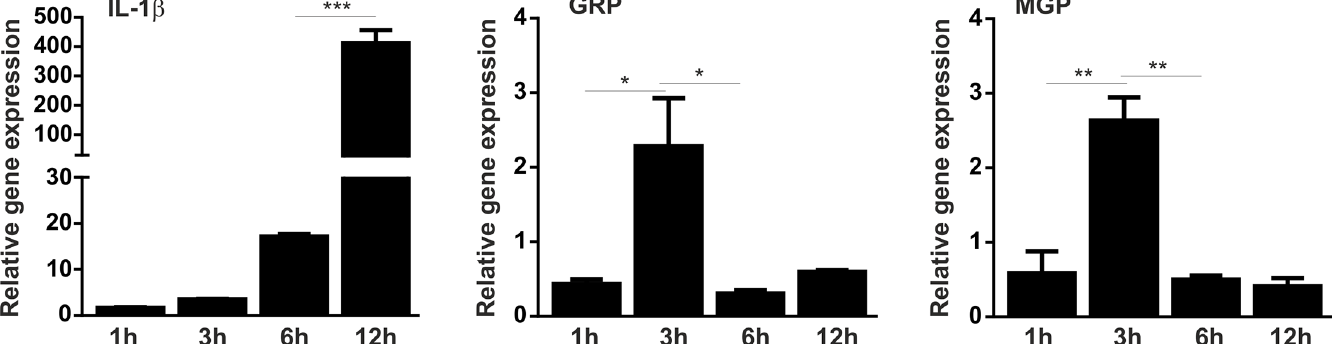
Fig 4. GRP and MGP are up-regulated in hydroxyapatite stimulated THP-1 MoM cells. Differentiated THP-1 macrophage cells were stimulatedwith 250 μ g/ml of synthetic hydroxyapatite nano-crystals and harvestedfor RNA extraction at determined time points during12h. Relativegene expression analysisof the inflammatory marker IL-1 β , GRP and MGP was determined by qPCR at indicatedtime points. Gene expressionlevels are relative to the expressionof control untreatedcells during each time point. GAPDH was used as housekeeping geneand data is presented as means (n = 3) ± standard error of duplicatesof two independent experiments. Ordinary one-wayANOVA was used and multiple comparisons were achievedwith Tukey’s test. Statistical significancewas definedas P < = 0.05 ( * ), P < = 0.01 ( ** ), and P < = 0.001 ( *** ).